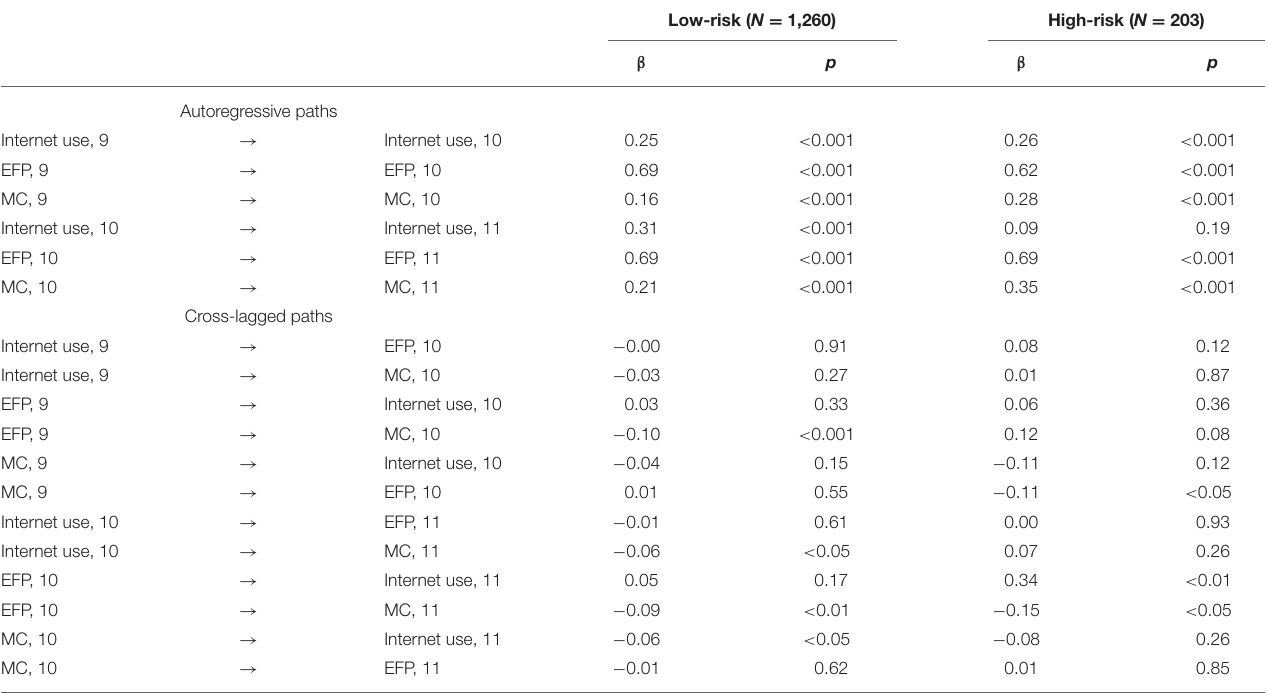
TABLE 2 | Standardized path coefficients in the low-risk and the high-risk